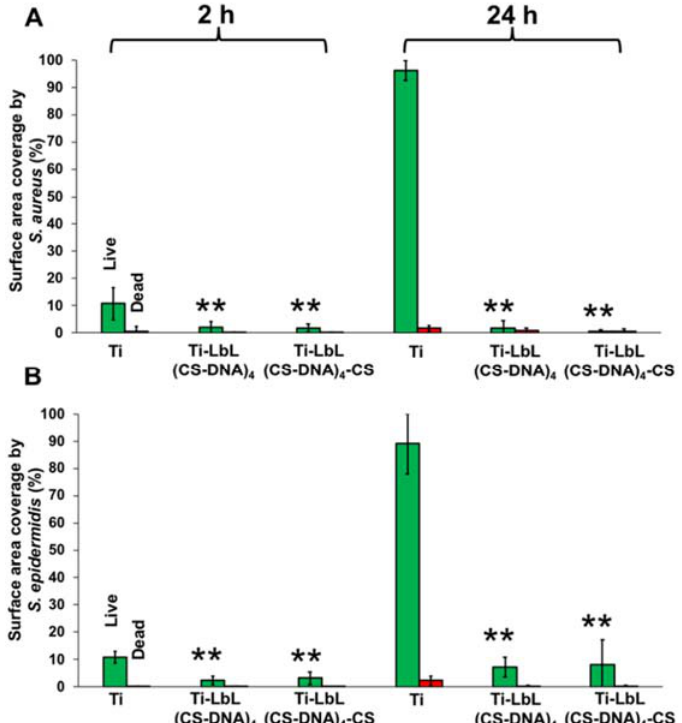
Figure 7. Surface coverage of adherent live (green bars) and dead (red bars) bacteria. ( A ) S. aureus ATCC 12598 and ( B ) S. epidermidis ATCC 35984 on uncoated and multilayer-coated Ti surfaces after incubation at 37 °C for 2 h and 24 h. Ti-LbL(CS-DNA) 4 has a DNA top layer, and Ti-LbL(CS-DNA) 4 - CS has a CS top layer. The error bars represent the standard deviation over three biological replicates. ANOVA tests were performed followed by a Tukey’s HSD post hoc test, and a p -value < 0.05 was considered significant. ** denotes significance ( p < 0.01) compared to uncoated Ti.